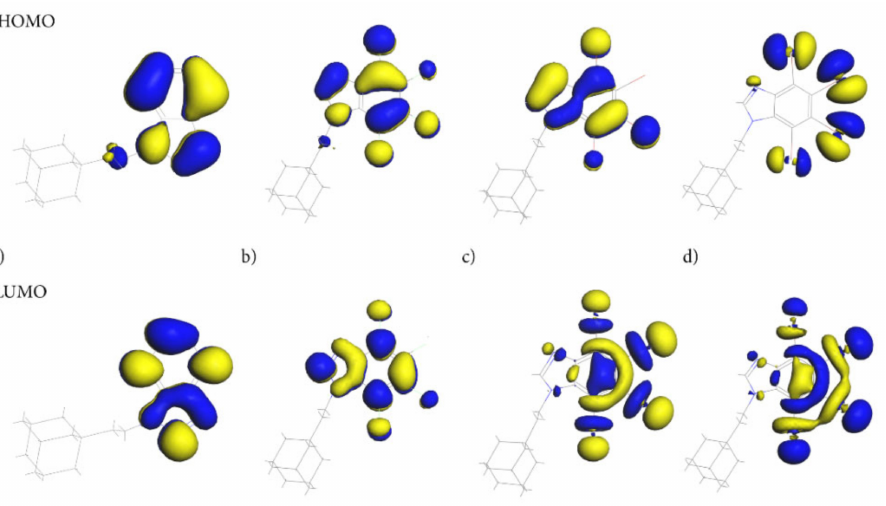
Figure 9. The Highest Occupied Molecular Orbital (HOMO) and the Lowest Unoccupied Molecular Orbital (LUMO) for adamantylated 4,5,6,7-tetrahalogeno-1 H -benzimidazoles ( a ) AB, ( b ) tClAB, ( c ) tBrAB and ( d ) tBrAB. The blue represents the positive phase of the wave function and yellow represents the negative phase of the wave